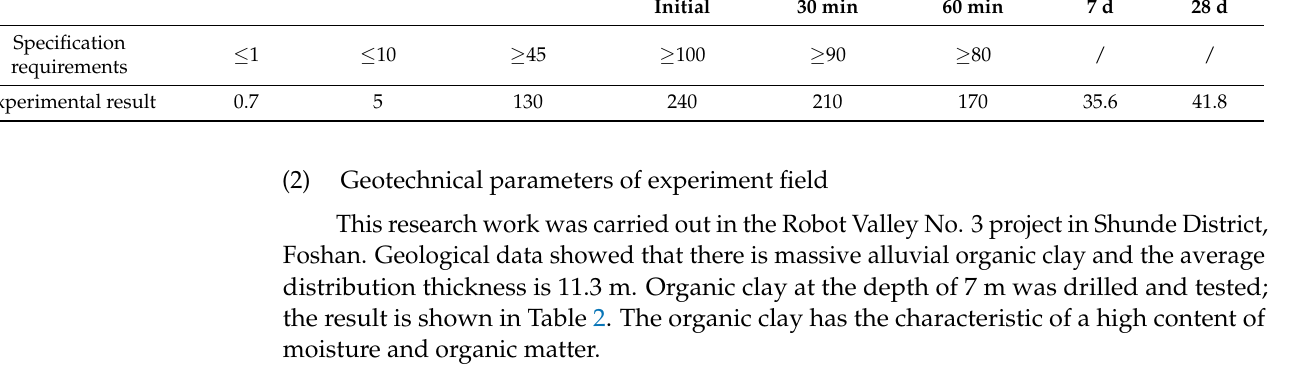
Table 2. Basic properties of engineering soil.